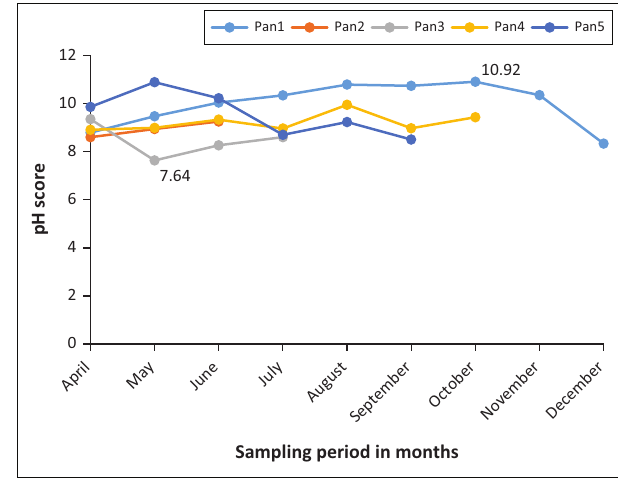
FIGURE 4: Range of pH readings at five pans in Gras-Holpan between April and December 2019, where Pans 2 and 3 were in the savanna biome and Pans 1, 4 and 5 in the Nama-Karoo biome. The dashed lines are the known range of tolerance for macro-invertebrates.